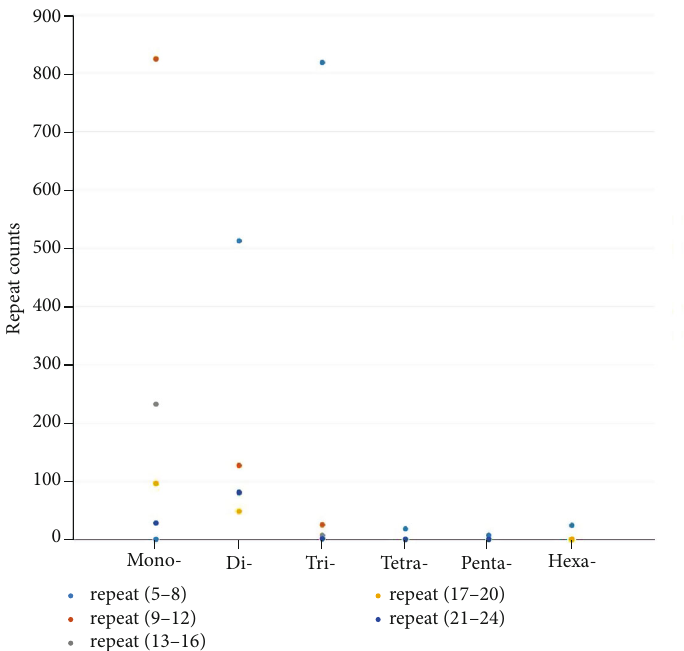
Figure 2: Transcript families and their corresponding numbers of TFs in the tiger lily.